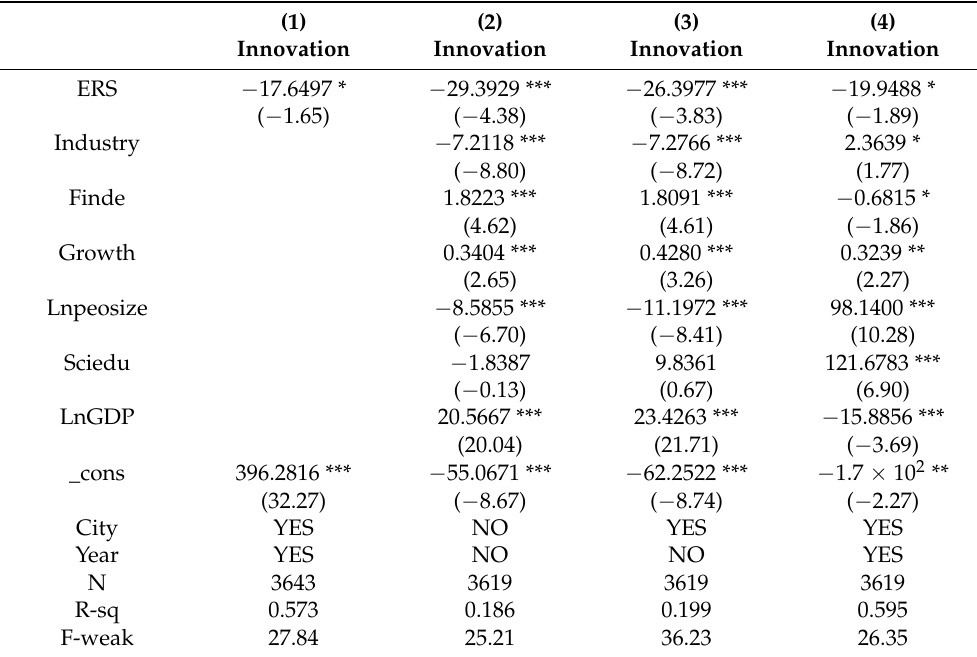
Table 9. Endogeneity test with the inclusion of the instrumental variable (air circulation